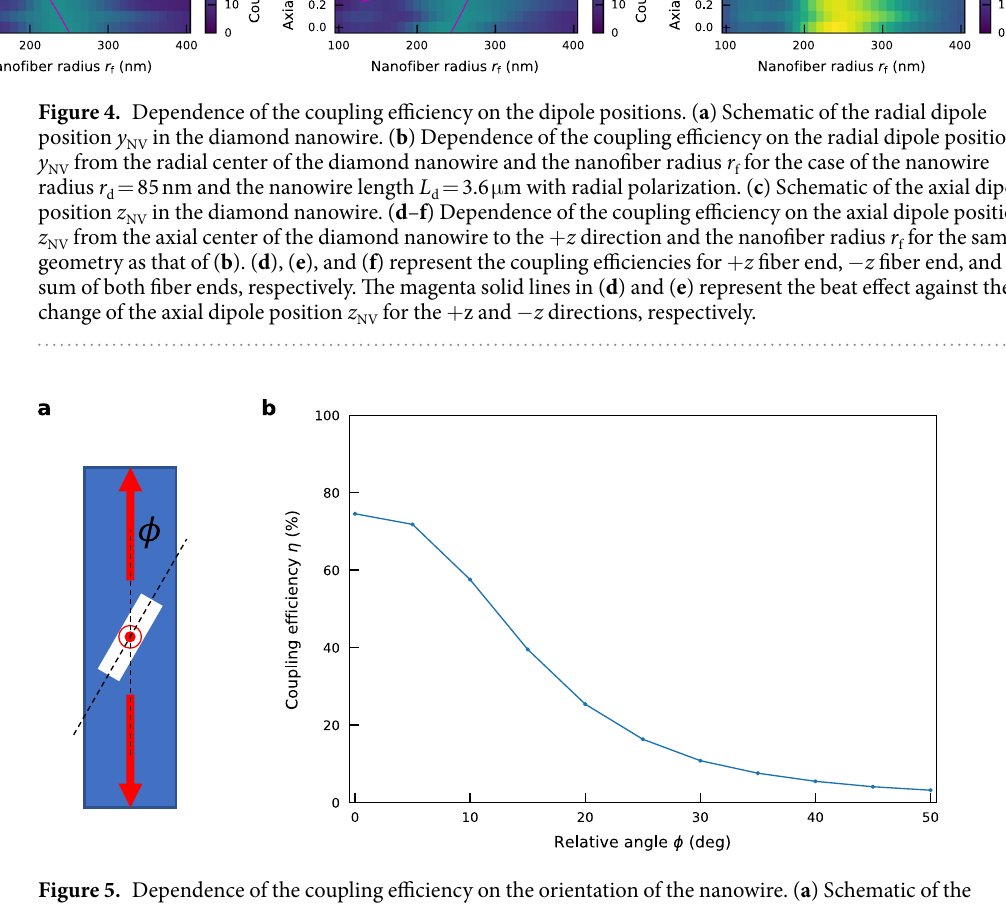
Figure 5. Dependence of the coupling efficiency on the orientation of the nanowire. ( a ) Schematic of the relative angle φ between the nanofiber and the diamond nanowire. ( b ) Dependence of the coupling efficiency on the relative angle φ for the case of the nanofiber radius = r 240 nm, the diamond nanowire radius = r 85 nm, f d and the diamond nanowire length = L 3.6 μ m with radial d nanofiber and the diamond nanowire. The nanowire radius r d = 85 nm, the nanowire length L d = 3.6 μ m, and the nanofiber radius r f = 240 nm are fixed again. The dipole is embedded in the center of the nanowire with the radial polarization. Figure 5b shows the dependence of the coupling efficiency on the relative angle φ . When the relative angle φ becomes larger than 20°, the coupling efficiency monotonously decreases below 25% (comparable to the spherical nanocrystal case). Therefore, a precise positioning of the nanowire utilizing nanowire manipu- lation techniques, such as atomic force microscopy (AFM) manipulation 53,54 and optical tweezers 55,56 , is indis- pensable towards the experimental realization of the proposed system. Note that a deterministic pick-and-place operation of a 12 μ m long diamond waveguide on the nanofiber with the radius of 250 nm by using a tungsten